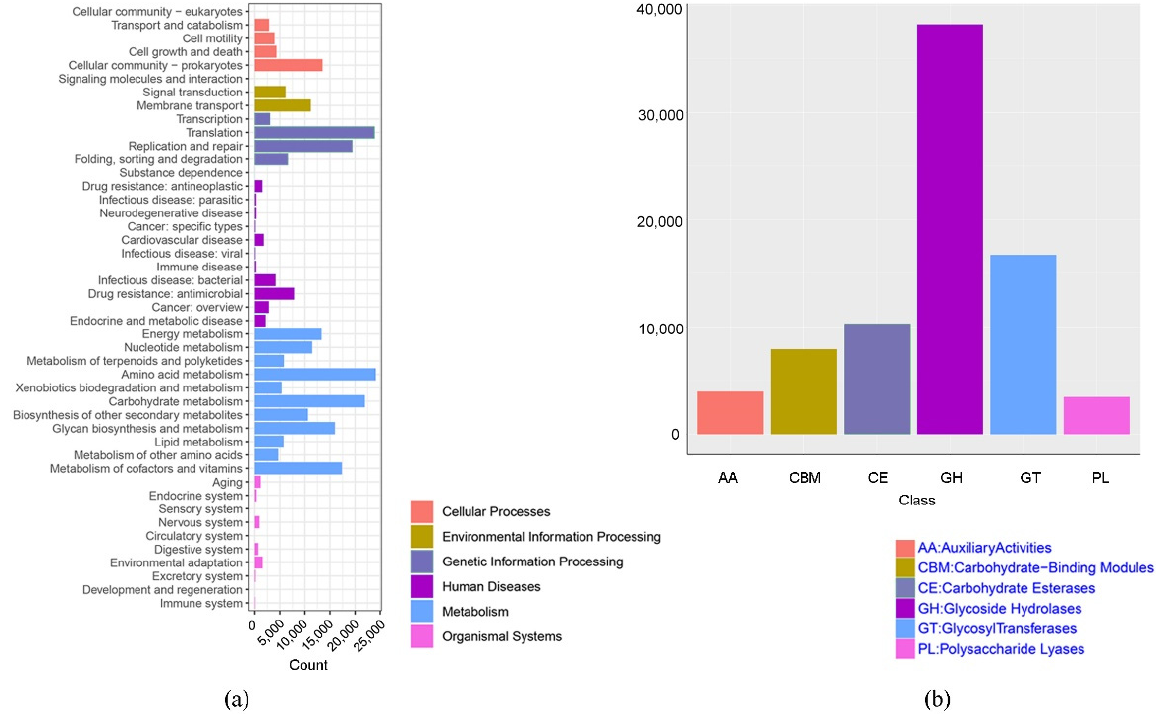
Figure 4. ( a , b ) Bar plots showing the relative abundance of genes associated with ( a ) the given KEGG pathways; and ( b ) CAZymes classes.